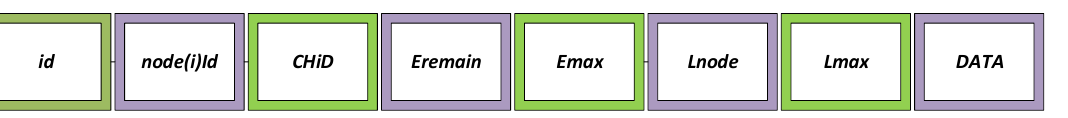
Figure 6. Packet format transferred in the network. Table 3. The segment descriptions of the packet format.